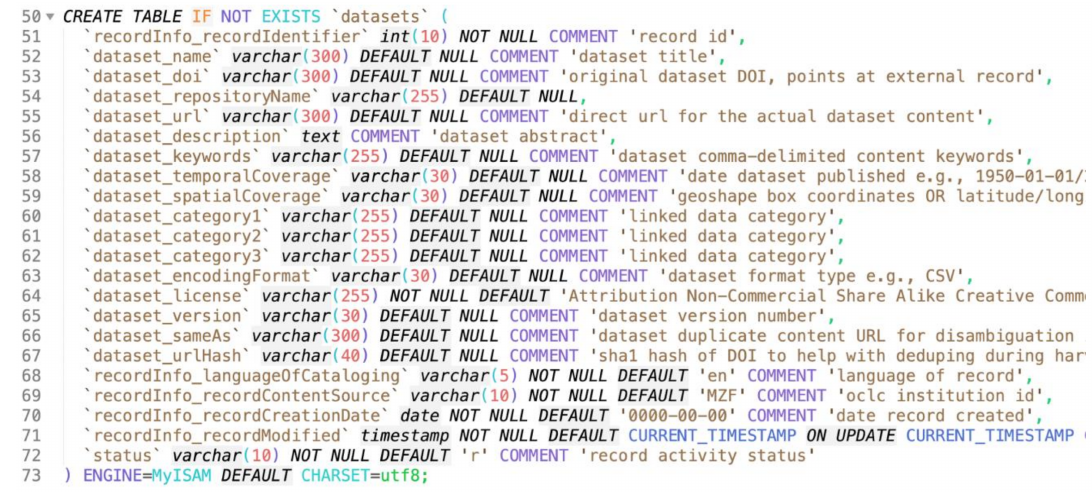
Figure 6. Metadata Fields in “Datasets”